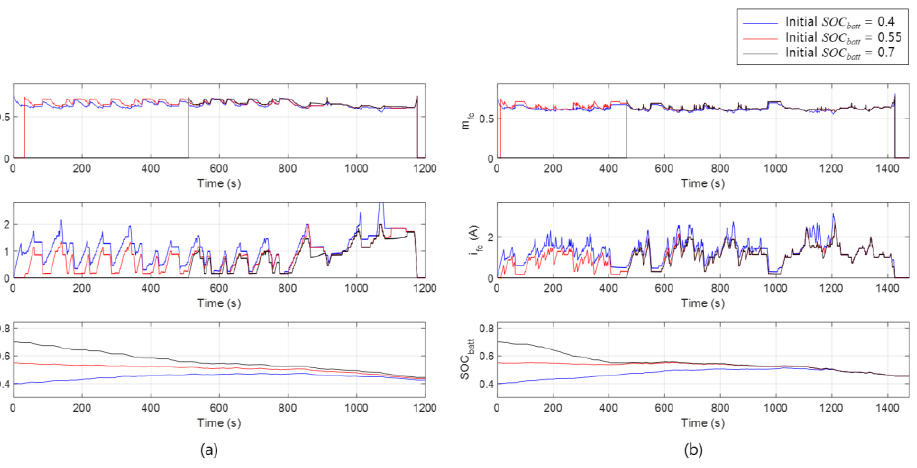
Figure 5. Dynamic programming results when the initial battery SOCs are 0.4, 0.55, and 0.7, respec- tively: ( a ) NEDC driving cycle; ( b ) WLTC driving cycle. Table 3. Trip costs of the simple EMS and DP-based EMS.